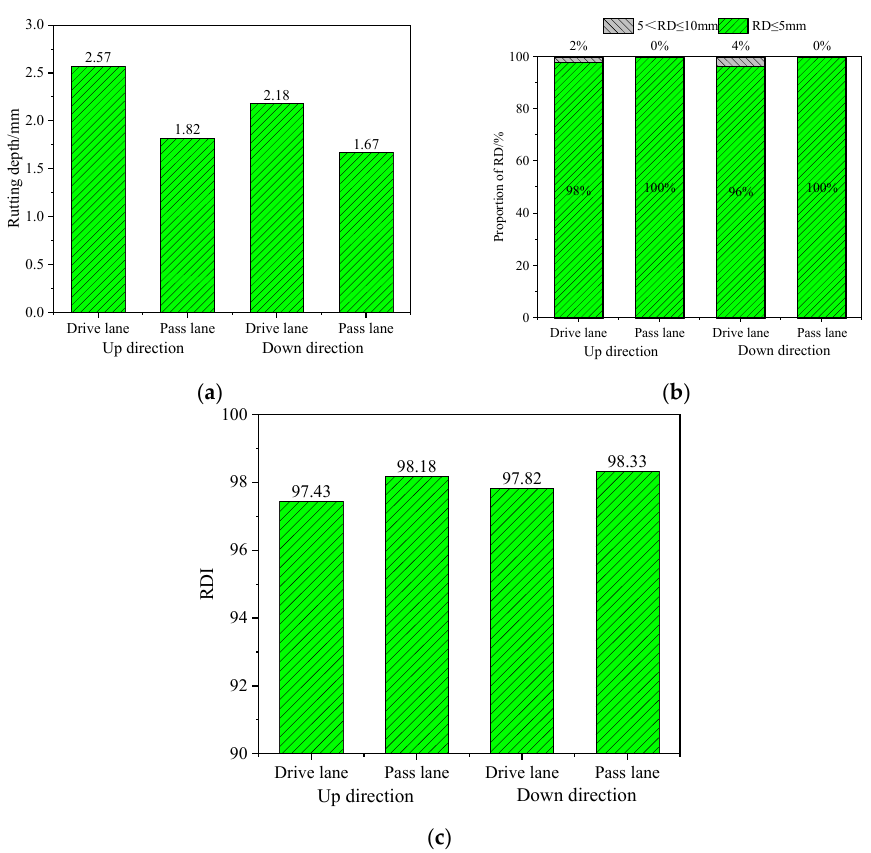
Figure 5. Rutting condition of XHMB pavement: ( a ) average RD; ( b ) RD distribution; ( c ) average RDI.